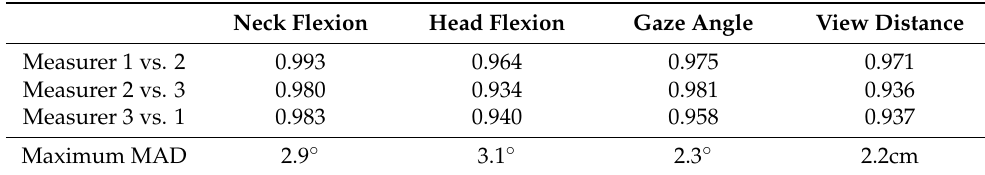
Table 2. Correlation analysis (r) of interobserver reliability between any two measurers and maximum mean absolute difference (MAD) among three measurers.